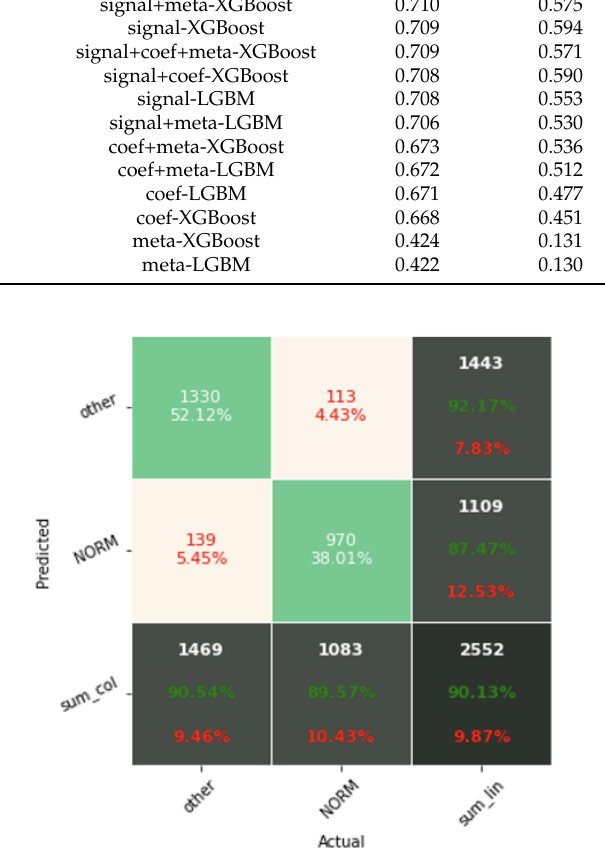
Figure 17. Confusion matrix of the best model in classification for 2 classes.